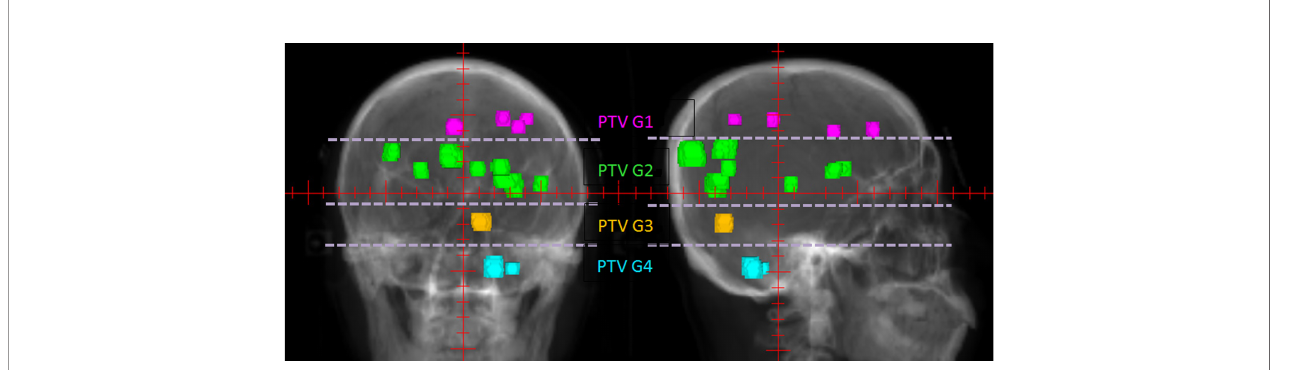
FIGURE 1 | An example of PTV groups in 0° and 90° BEVs. The patient had 14 BMs, which were longitudinally divided into four groups marked by different colors according to their